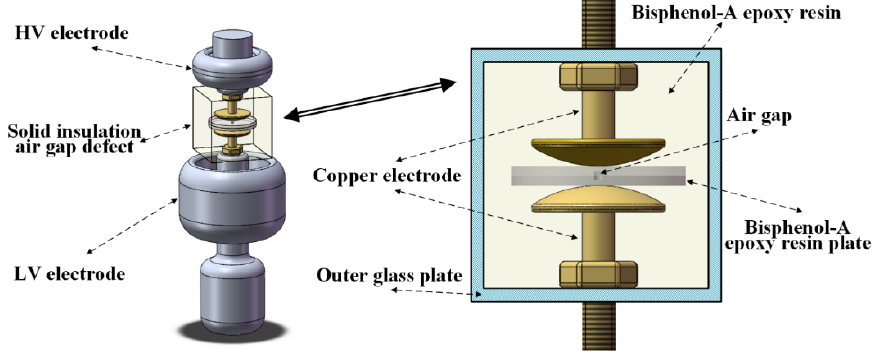
Figure 2. The schematic diagram of solid insulation air gap defect.